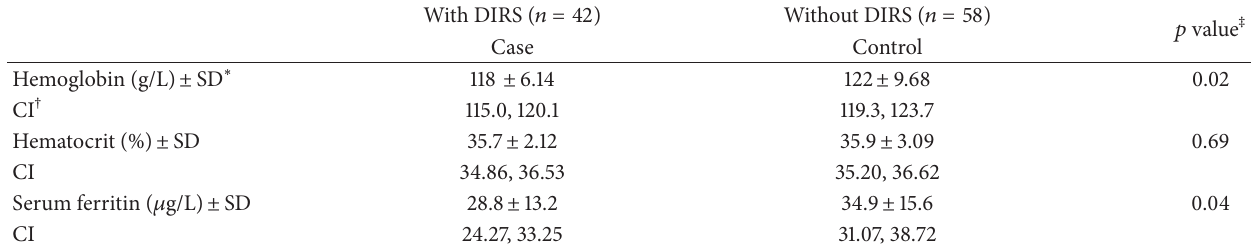
Table 2: Comparative analysis between children with DIRS and those